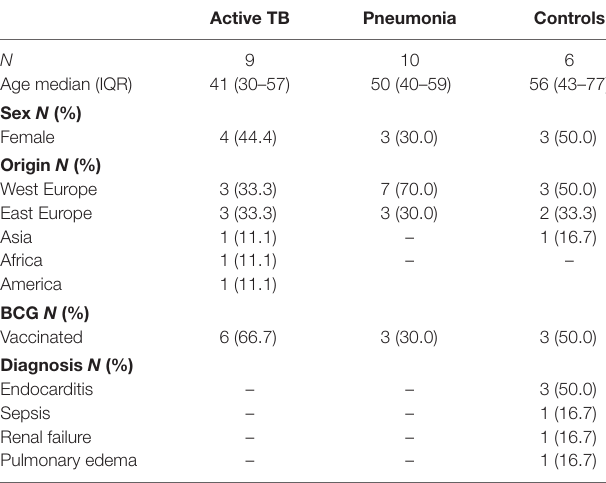
TaBle 2 | Demographical and clinical characteristics of the patients whose autopsies samples were evaluated by